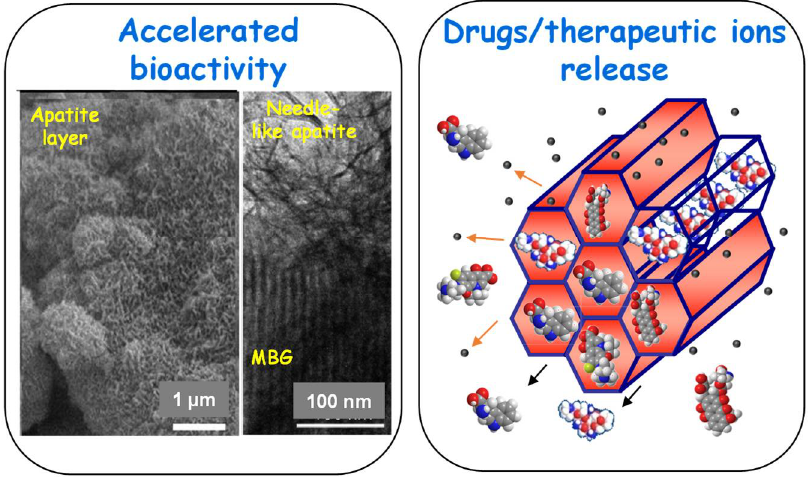
Figure 3. Main properties of mesoporous bioactive glasses (MBGs). Left: improved bioactive behavior. Right: ability to load and release drugs/therapeutic ions in a controlled manner. Black arrows indicate the release of drug molecules; orange arrows show the lixiviation of therapeutic ions.